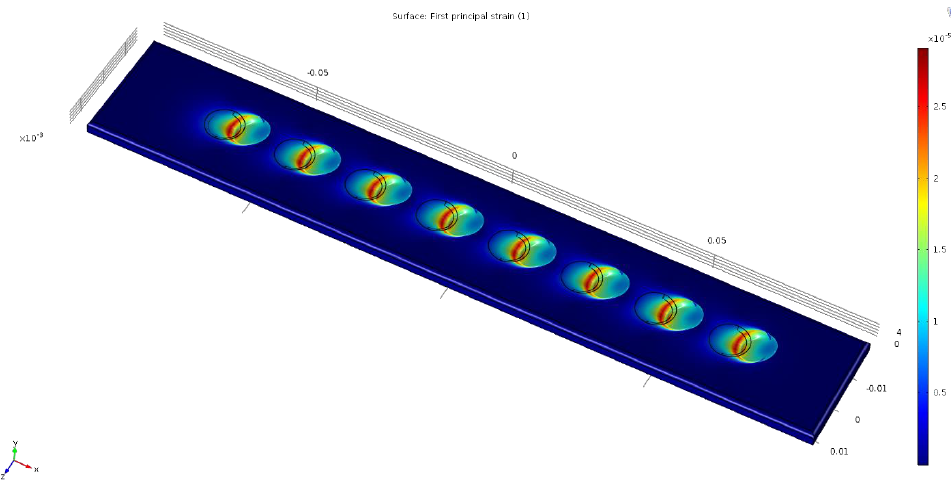
Figure 8. First principal strain of traditional flat plate.